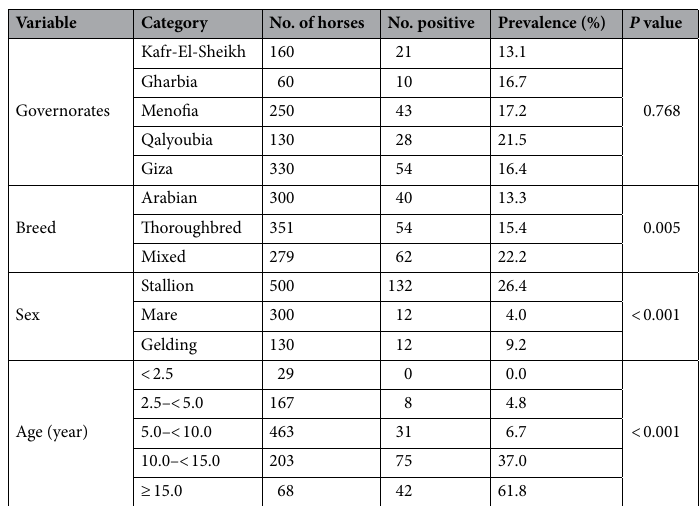
Table 2. Univariable logistic regression analysis of the association of horse-level West Nile virus infection with different risk factors in the Nile Delta of Egypt.